Question: Give a one-sentence summary of this figure.
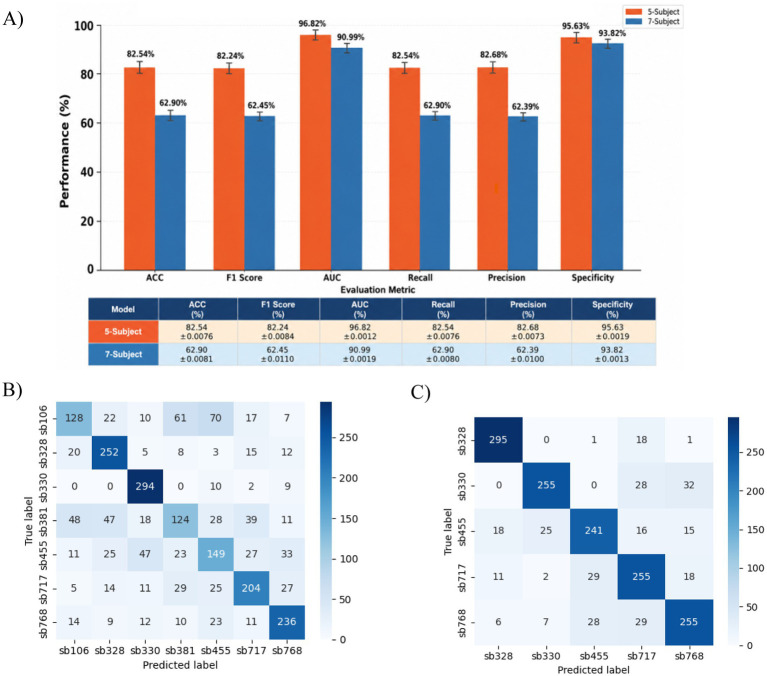
Answer: Performance evaluation and comparison of 5-subject and 7-subject experiments. (A) SVM based model performance for 5-subject and 7-subject experiment, (B) confusion matrix for 7-subject experiment, (C) confusion matrix for 5-subject experiment.